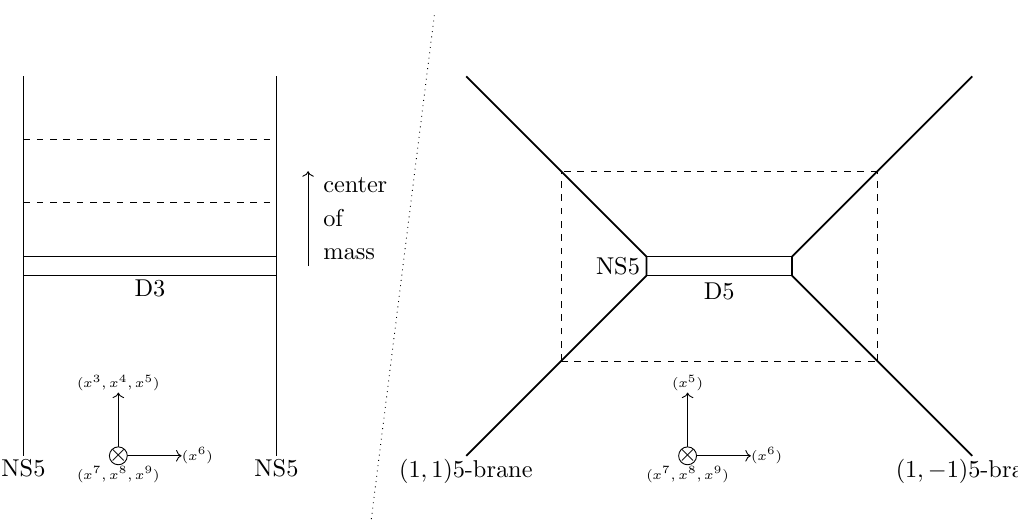
Figure 2 . Depicted are Type IIB brane configurations with supersymmetric gauge theories living on the lightest branes. A different point in their moduli space is depicted with a dashed line. The 3d = 4 gauge theory living on the two D3 branes has 2 (quaternionic) Coulomb branch moduli, while N the 5d = 1 gauge theory living on the D5 branes has only one (real) Coulomb branch modulus, as N the center of mass is fixed. Hence the 3d theory has a U(2) gauge group at the origin of the moduli space, while the 5d theory has a SU(2) gauge group. Both have the Weyl group S 2 = Z 2 . Decoupling the center of mass of the D3 branes leads to a centerless U(2) / U(1) = SU(2) / Z 2 gauge group. A similar argument holds for 4d = 2 gauge theories living on D4 branes suspended between NS5 N branes in Type IIA, which is a T-dual configuration of the above. Because of the logarithmic bending of the NS5 branes the center of mass is fixed and the gauge group is SU(2). Moving the center of mass in the 4d or 5d case corresponds to changing the asymptotic behaviour [12]. The moduli space of the gauge theory corresponds to the brane motions which keep the asymptotic form of the heavy branes intact